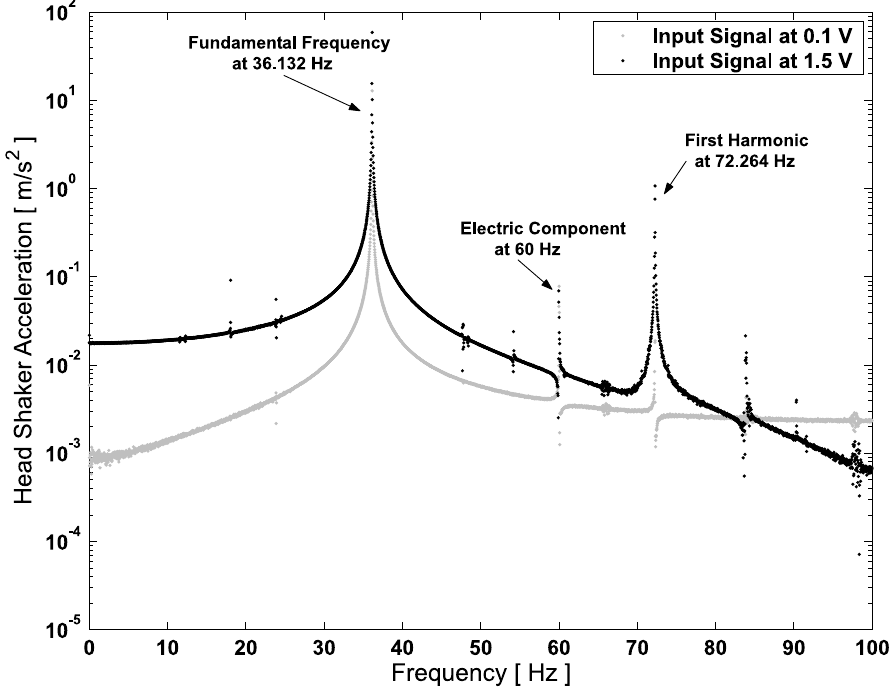
Fig. 6. Experimental result showing the presence of a harmonic in the shaker’s response, even when the input (voltage) has got only one spectral component fixed at 36.132 Hz. in which φ ( x ) represents the first linear natural mode of the structure and w o ( t ) represents the modal coordinate associated with this natural mode. As a final result, the expressions for ( ˙ u o 1 )